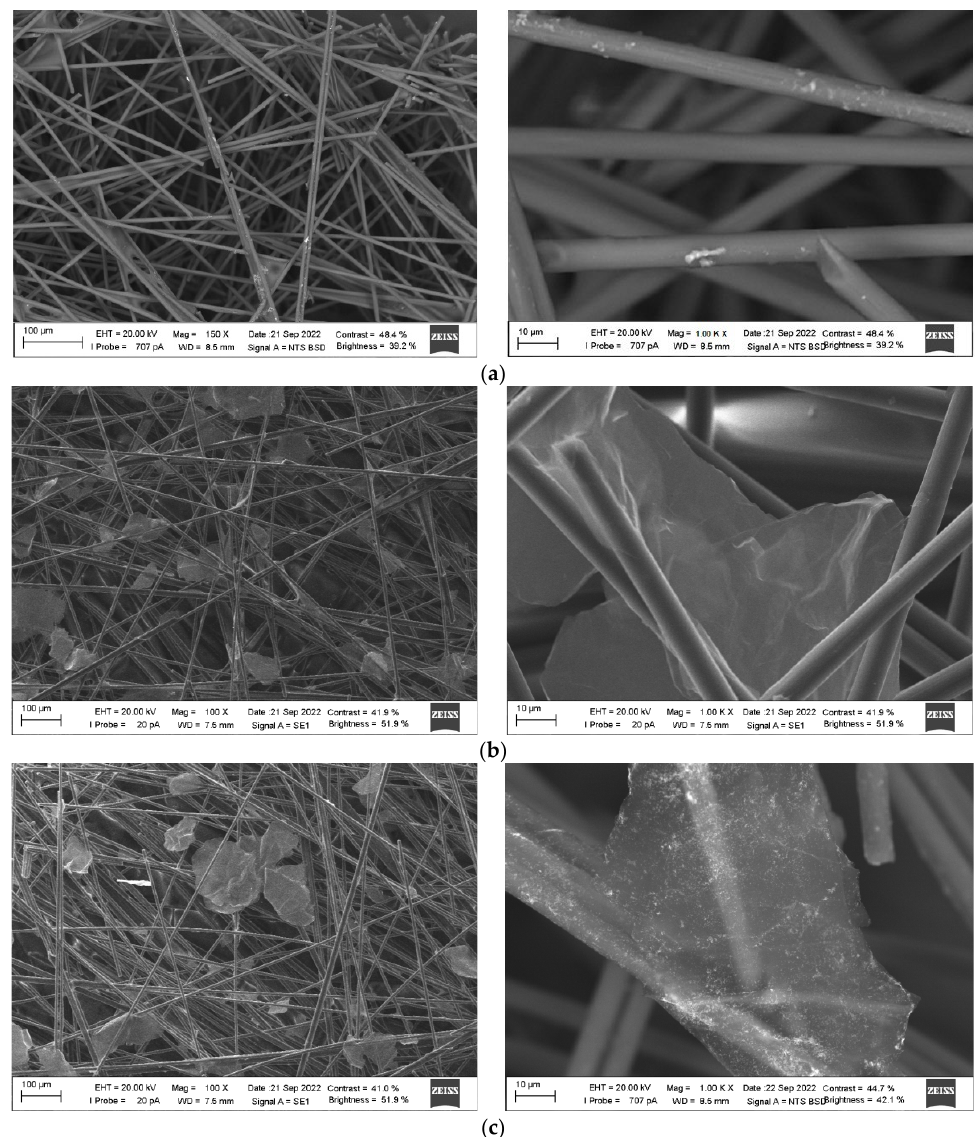
Figure 4. SEM images of bare CP ( a ), CP modified with PDDA-G ( b ) and CP modified with phyto-AuNPs/PDDA-G ( c ).